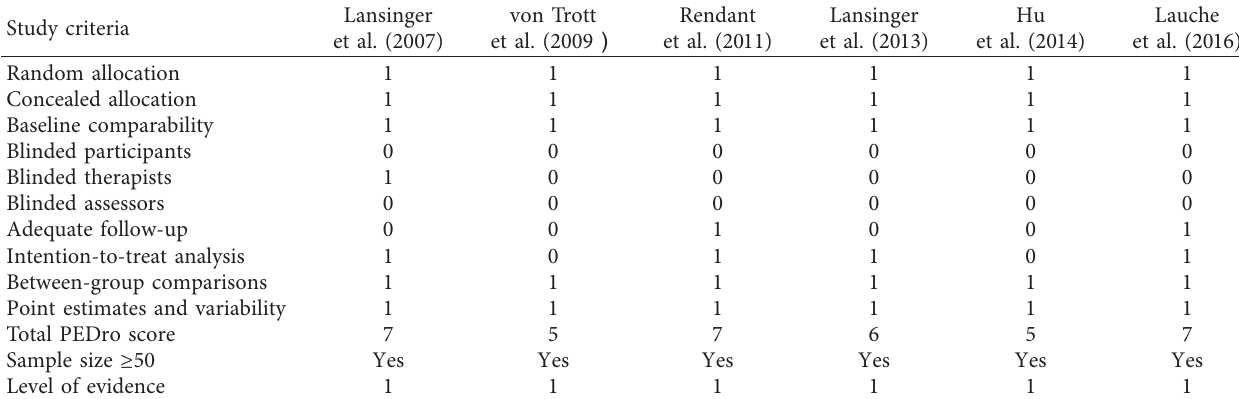
Figure 1: Preferred Reporting Items for Systematic Reviews and Meta-Analyses flow chart of research for this meta-analysis. RCT: randomized controlled trial; TCMBE: traditional Chinese mind and body exercise. Table 1: PEDro scale scores and levels of